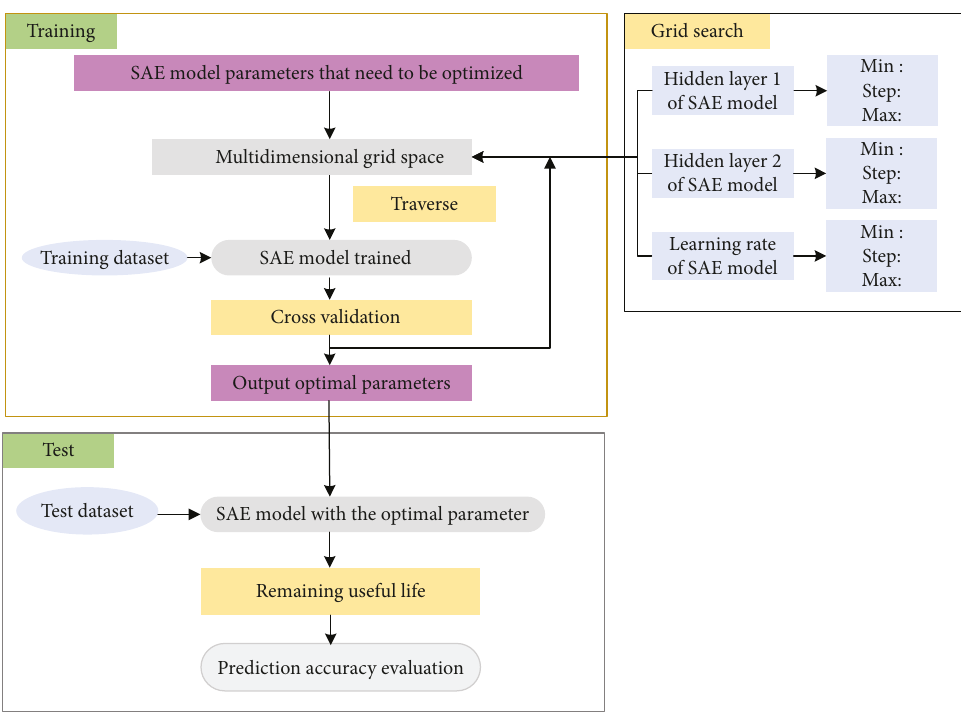
Figure 7: Grid search-based SAE RUL prediction model parameter optimization and validation.